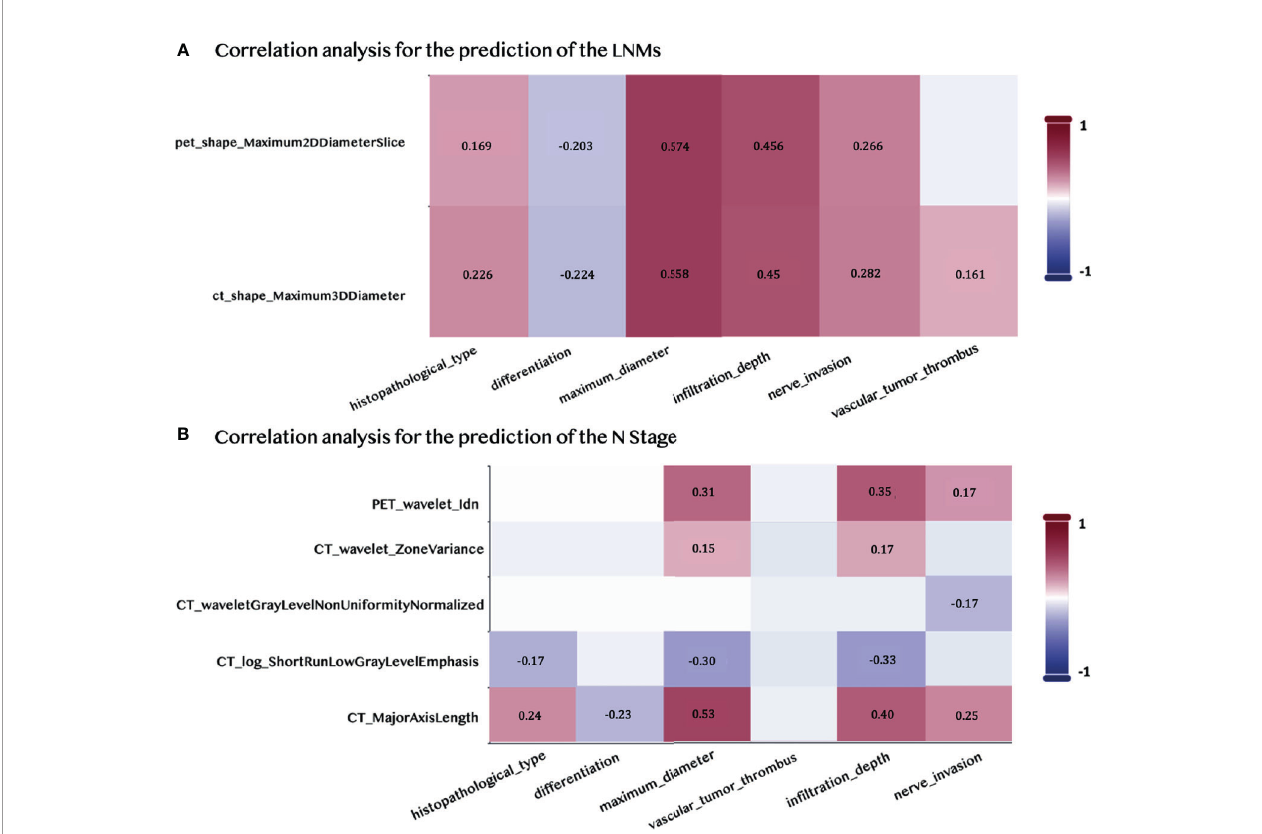
FIGURE 6 | Pearson Correlations between the selected PET/CT features and the pathological features. (A) Correlation analysis for predicting LNMs. (B) Correlation analysis for predicting the N stage. Pairwise correlations with p < 0.05 are shown in the fi